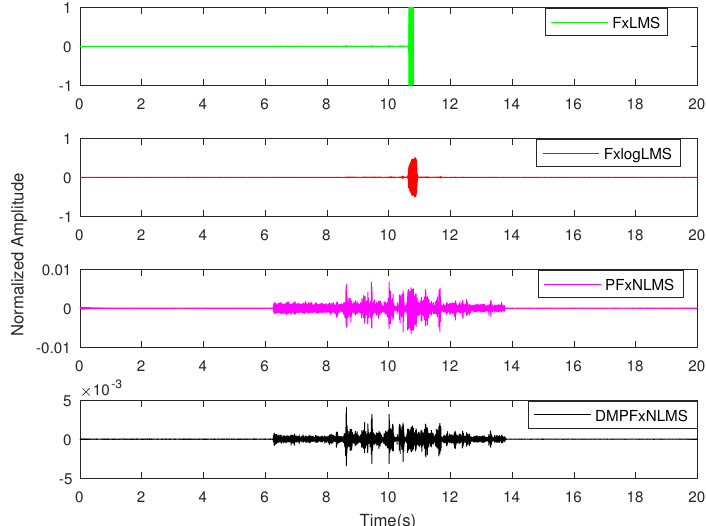
Figure 11. Performance comparison of noise in error learning curves.